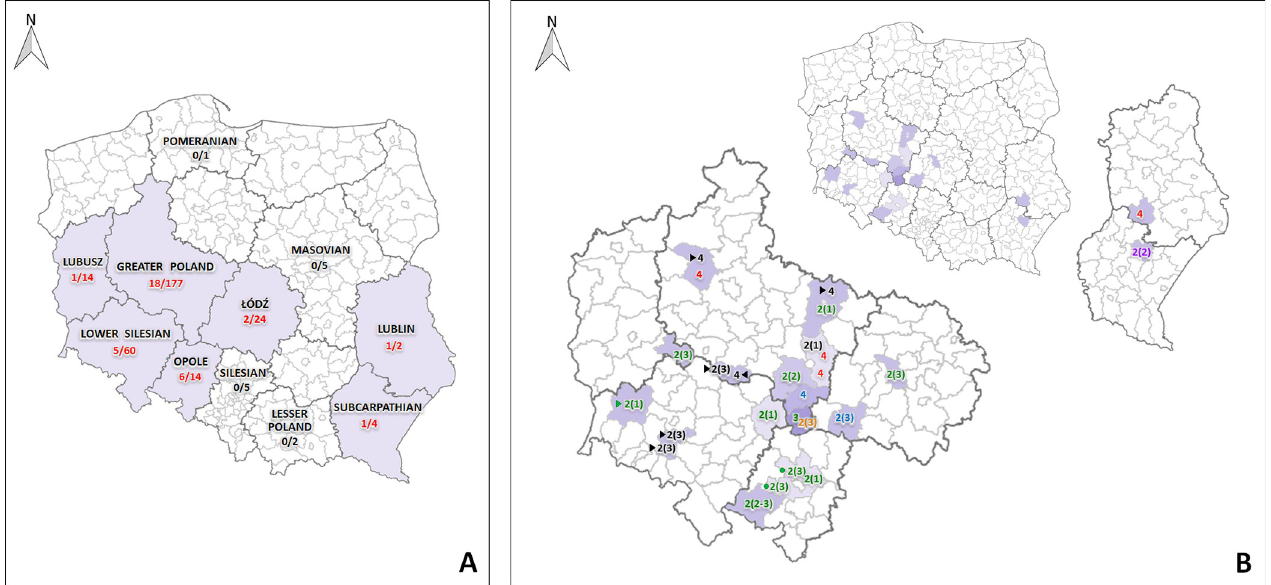
Fig 2. Geographical distribution and genotype classification of avian HEV viruses. (A) The location of voivodeships together with the number of infected flocks/number of tested flocks. (B) Poland is divided into voivodeships and counties. Farms belonging to the same industry are marked with a triangle or a circle symbol. Numbers in parentheses are referred to genotype 2 clusters. Commercial laying hen farms marked in black, breeder broiler farms in green, broiler farms in red, duck farms in blue, goose farms in orange and western capercaillies breeding facility in purple. Map reprinted and edited from [22]